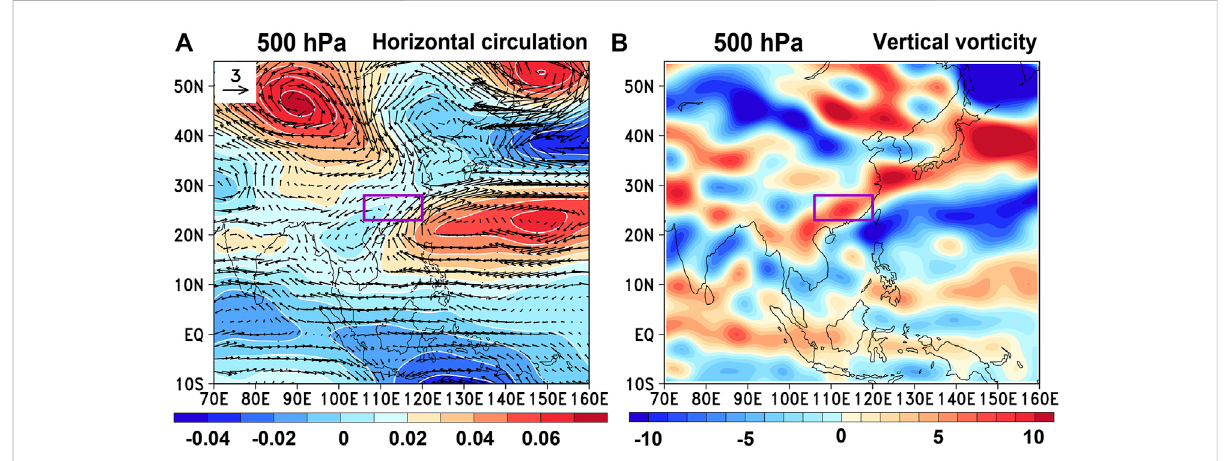
FIGURE 6 (A) Distribution of the horizontal circulation anomaly at 500 hPa during the “ Dragon Boat Water ” season in 2022. Shading and vector represent the stream function anomaly and wind anomaly of the horizontal circulation; (B) is the same as (A) but for the distribution of the vertical vorticity anomaly of horizontal circulationat 500 hPa. Units ofthe stream function, wind, and vorticity anomalies are 10 − 6 s − 1 , m s − 1 , and 10 − 6 s − 1 ,